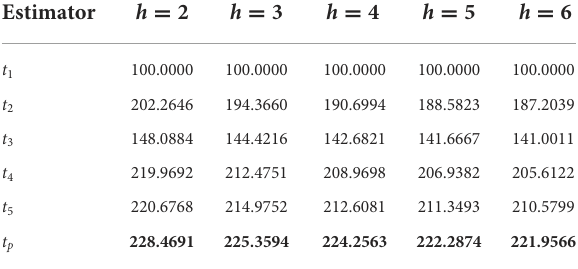
TABLE 7 PRE of different estimators with respect to t 1 for Population 6.